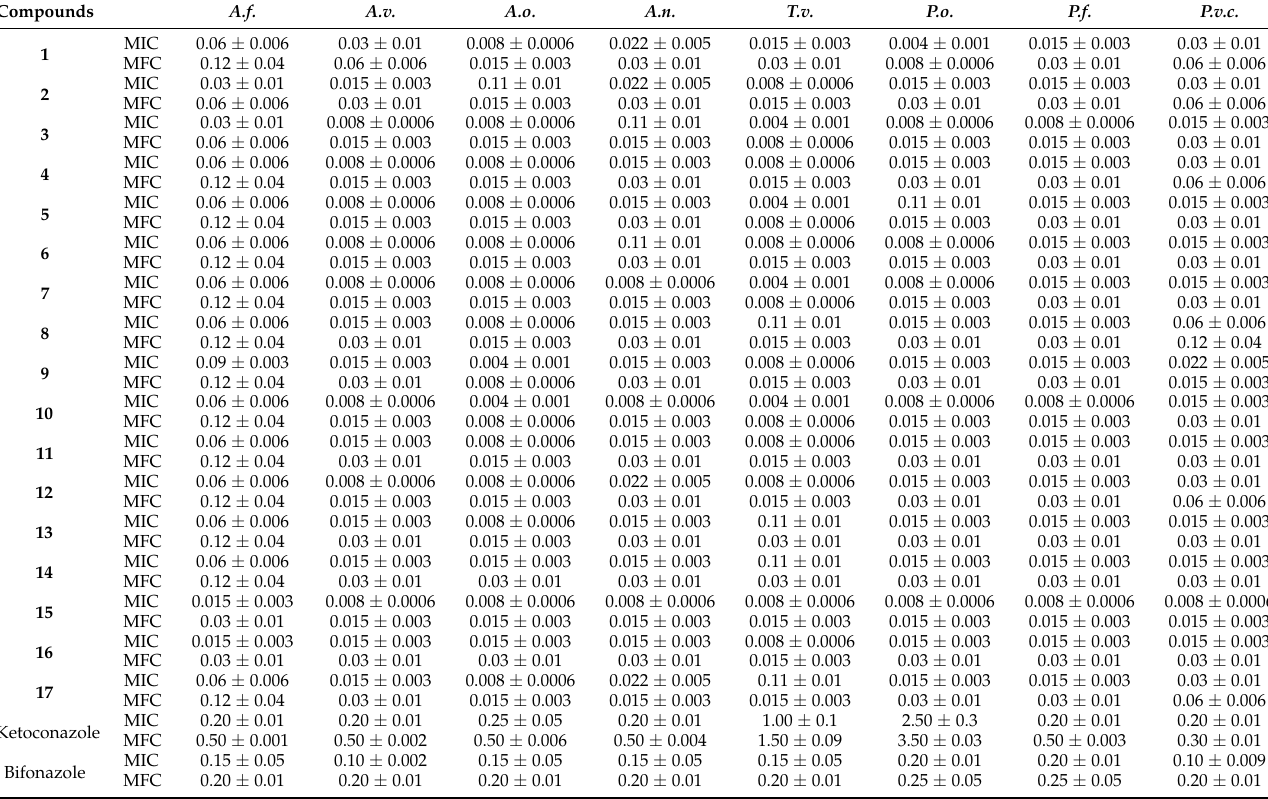
Table 3. Antifungal activity of target compounds (MIC and MFC in